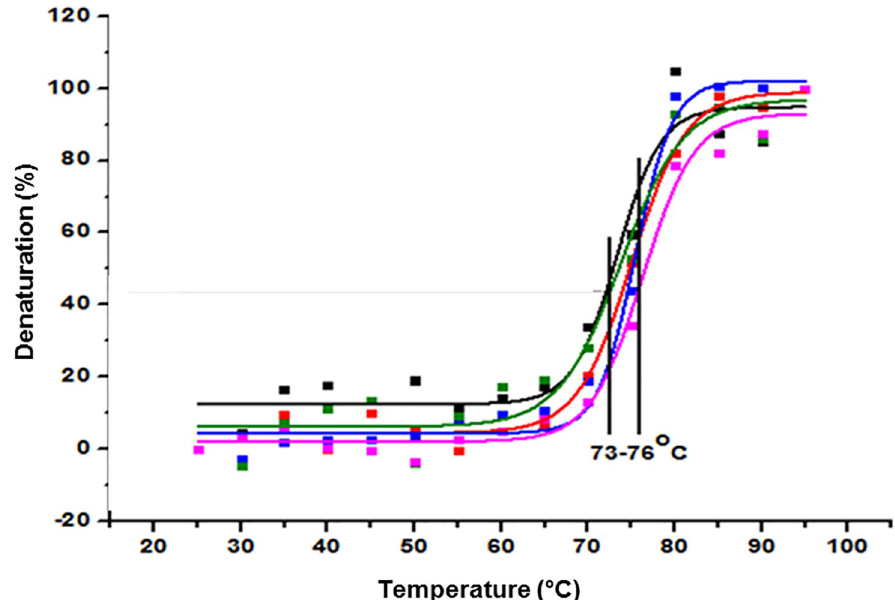
Fig 5. Thermal denaturation curves for 5G4 mAb and Herceptin in PBS solution. Different batches of the mAbs are shown. 5G4 mAb batch 1 (black), 5G4 mAb batch 2 (red), 5G4 mAb batch 3 (blue), Herceptin batch 1 (green) and Herceptin batch 2 (pink). The indicated region shows the temperature range corresponding to the Tm values obtained.